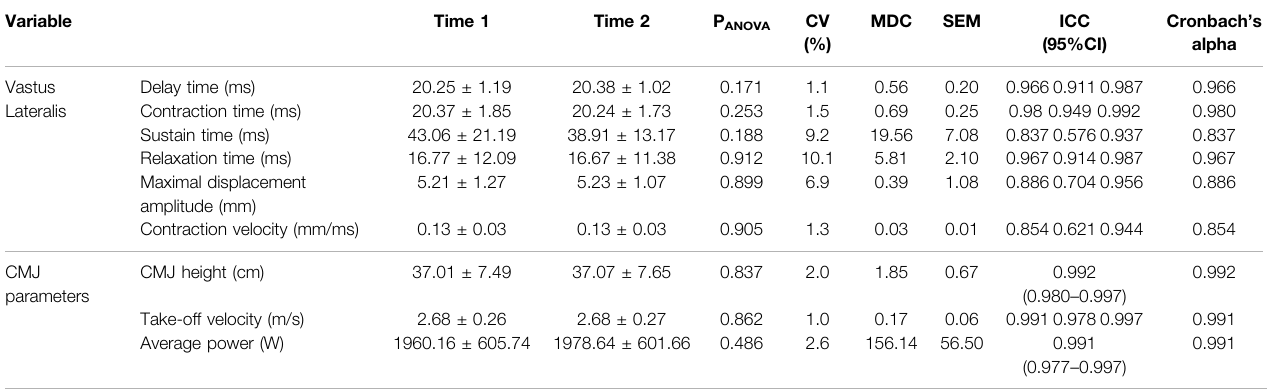
TABLE 1 | Between Time 1 and Time 2 reliability analysis of the TMG and CMJ performance parameters. Variable